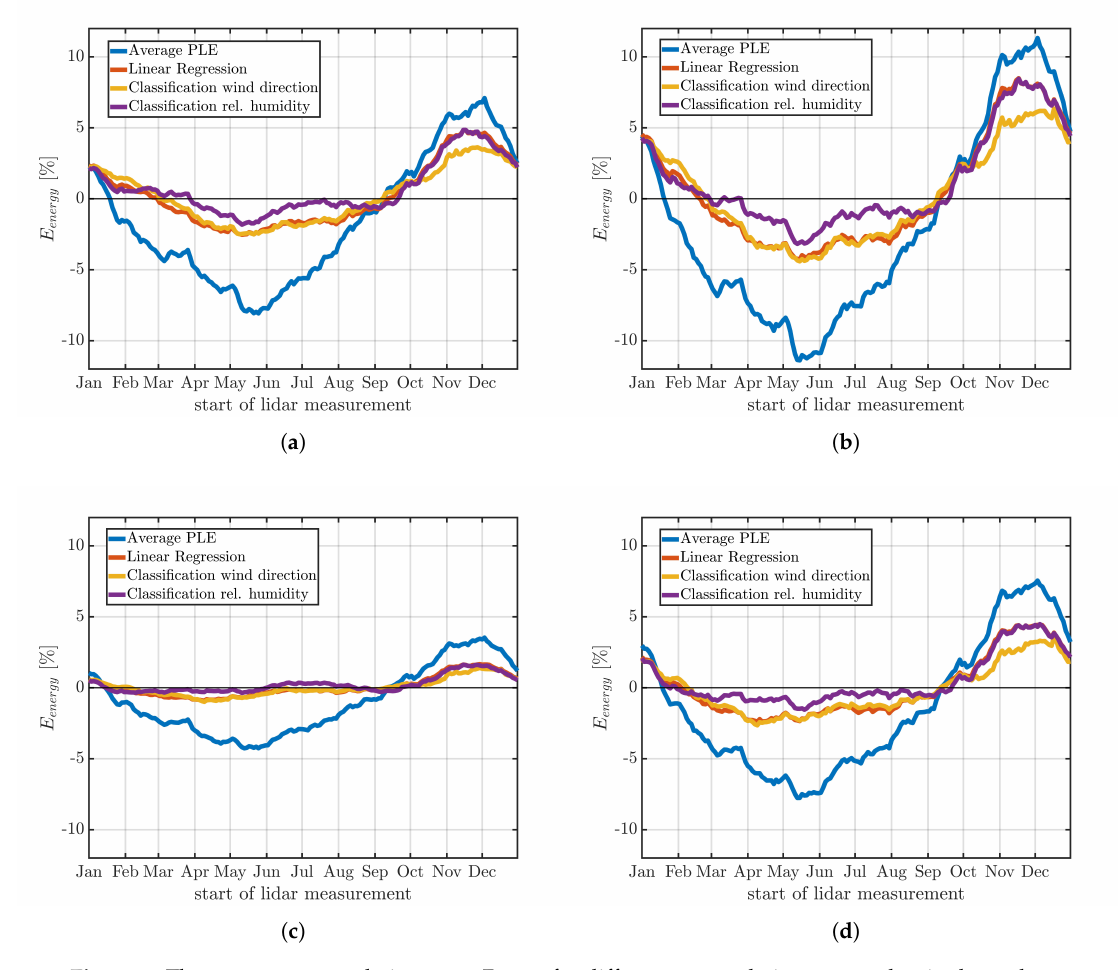
Figure 9. The average extrapolation error E energy for different extrapolation approaches in dependence of the start of the lidar measurement, for ( a ) z 2 = 80 m and z t = 140 m; ( b ) z 2 = 80 m and z t = 200 m; ( c ) z 2 = 100 m and z t = 140 m; ( d ) z 2 = 100 m and z t = 200 m. Selected lidar measurement duration: 60